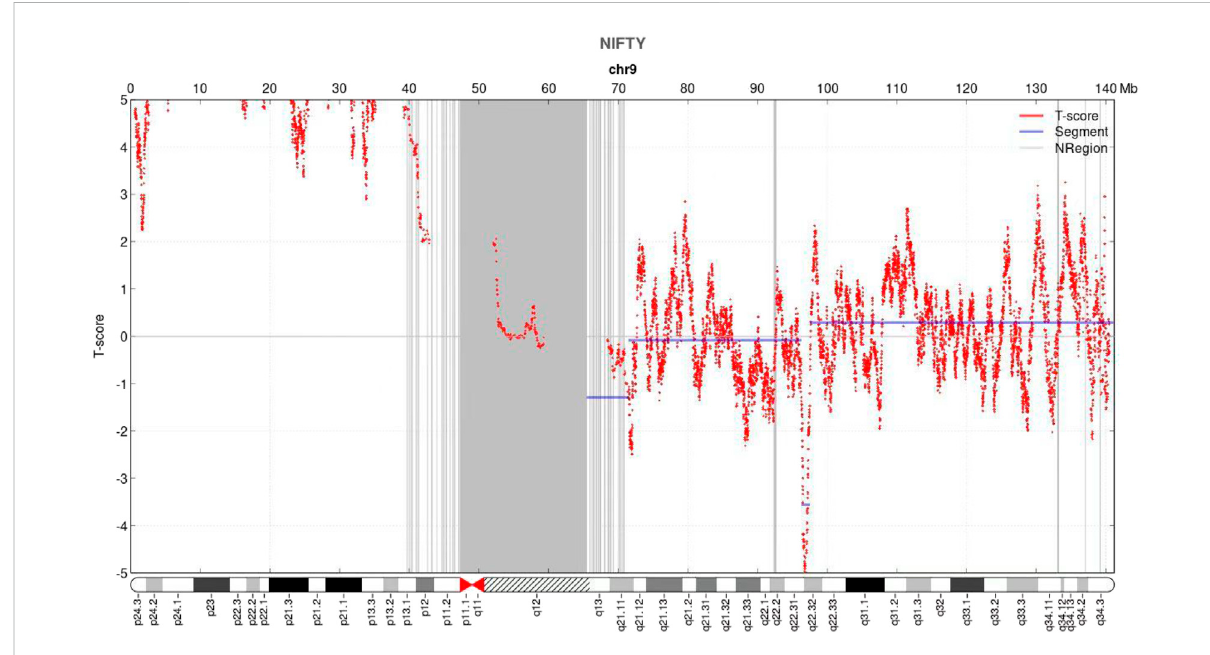
FIGURE 1 Non-invasive prenatal testing (NIPT) results of fetal chromosome 9. The horizontal axis represents genomic location (Mb), and the vertical axis represents t-score. NIPT revealed an increase in the signal of the p arm of chromosome